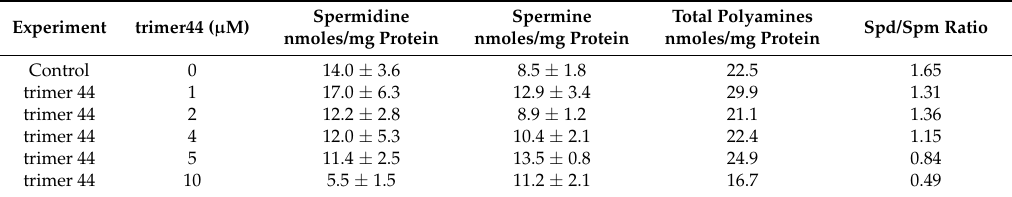
Table 2. Polyamine levels as a function of trimer44 concentration in L3.6pl cells incubated at 37 ◦ C for 72 h a